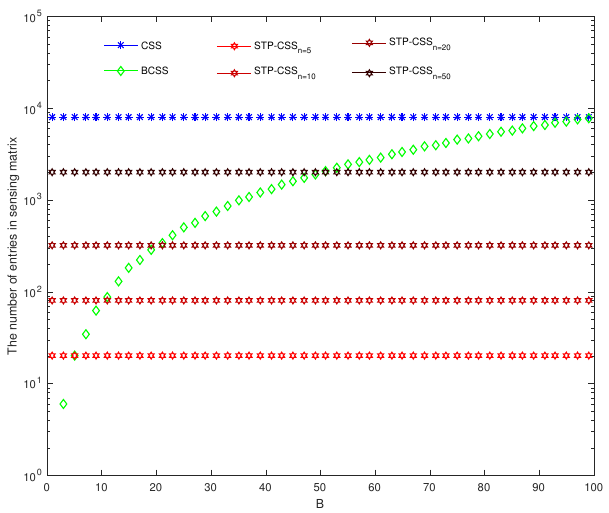
Figure 11. The comparison of storage performance in CSS, block-based compressed spectrum sensing (BCSS), and STP-CSS. The blue, green, and red lines represent CSS, BCSS, and STP-CSS, respectively. In the STP-CSS, the values of the columns n are set to 5, 10, 20, and 50.